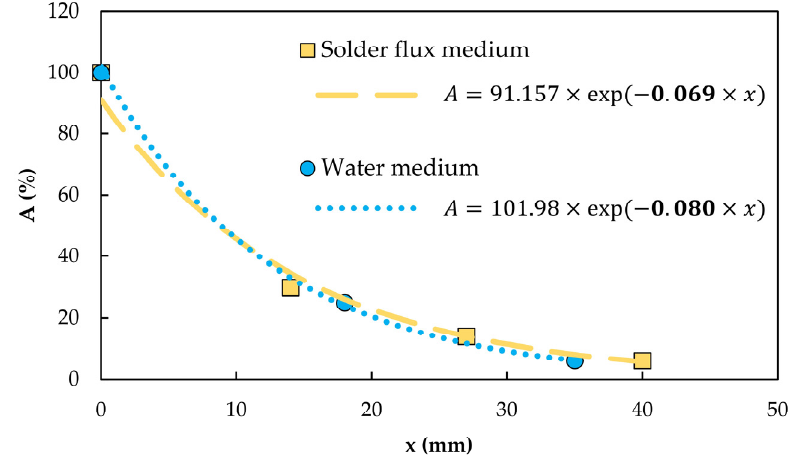
Figure 11. Soundwave amplitude (A) as a function of scanning depth (x) based on UT measurements with a 20 MHz conventional probe for solder flux and water media. The dashed lines represent the exponential fitting of the experimental data using the equations included in the figure.